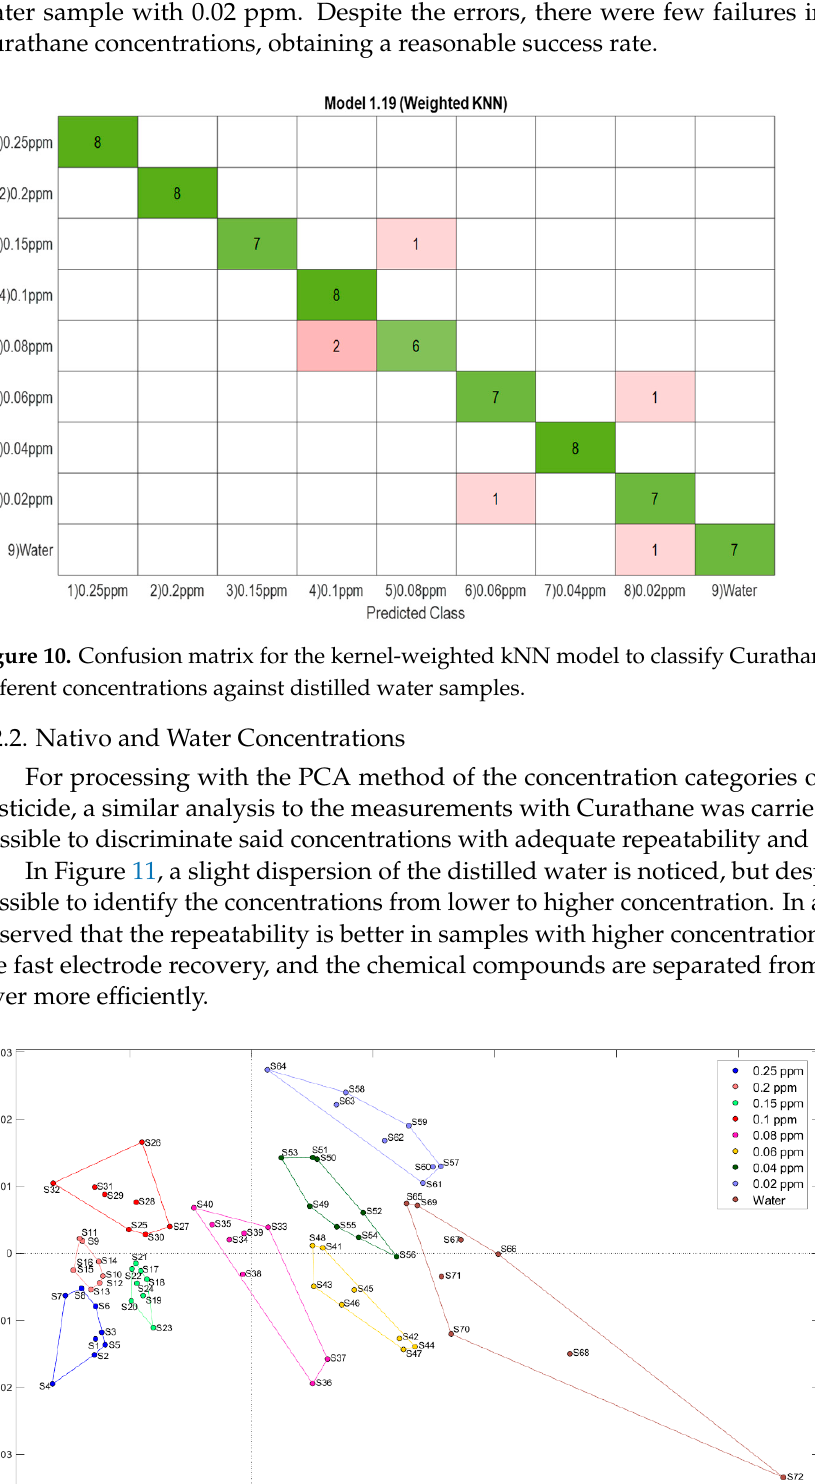
Figure 12. LDA plot by employing the carbon electrode (C110) for the Nativo pesticide classification at different concentrations.